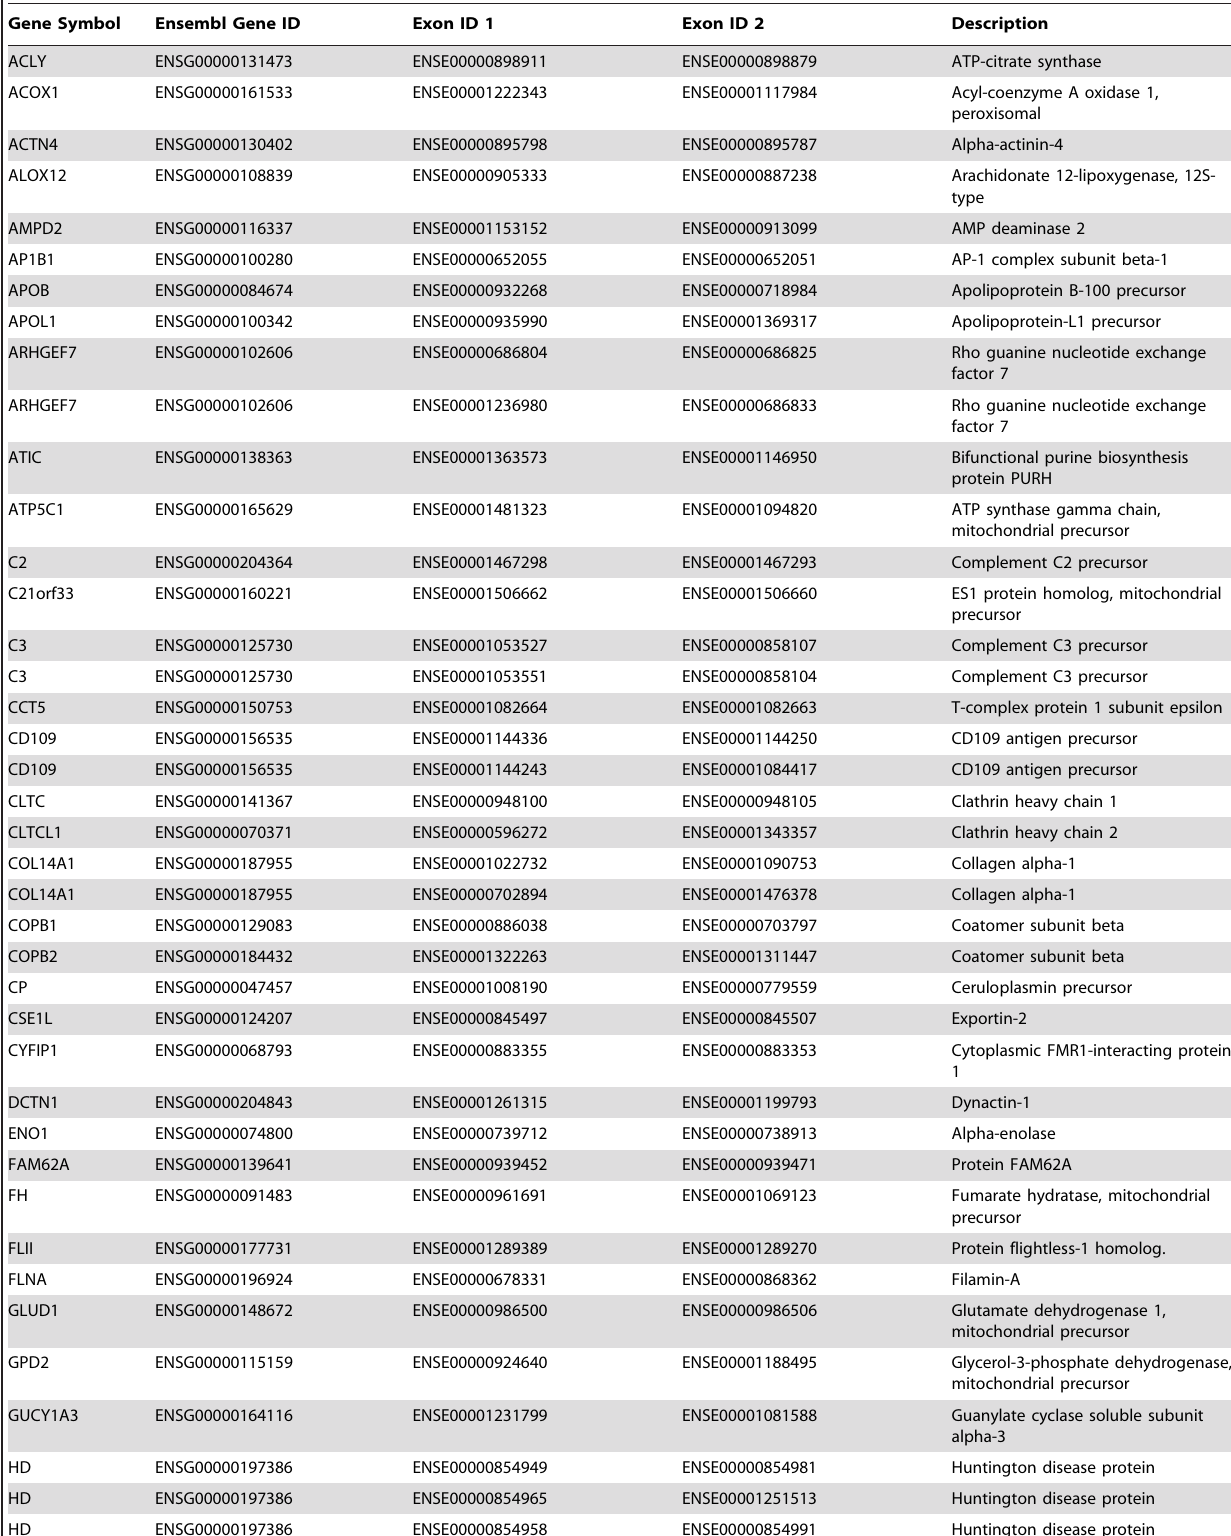
Table 1. Description of the 89 genes identified in both SkipE and